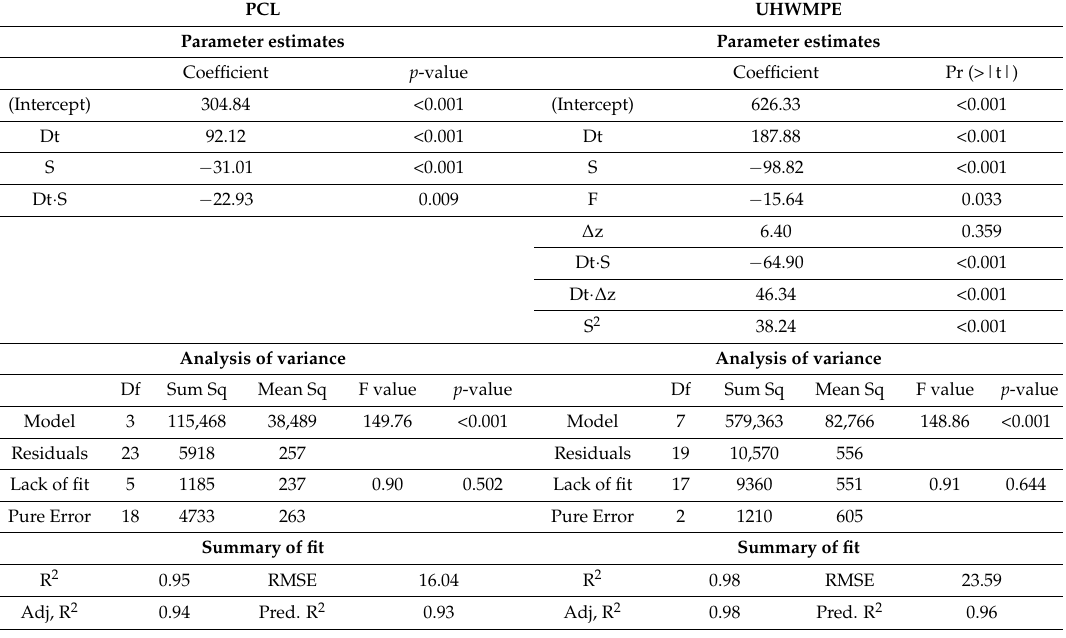
Table 3. Maximum force (Fz max) model